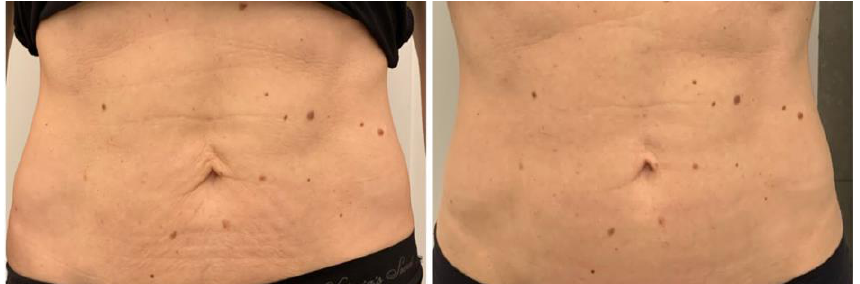
Figure 4. Abdominal frontal view of a female patient before and 1 month after treatment. A visible improvement in muscle tone can be observed.